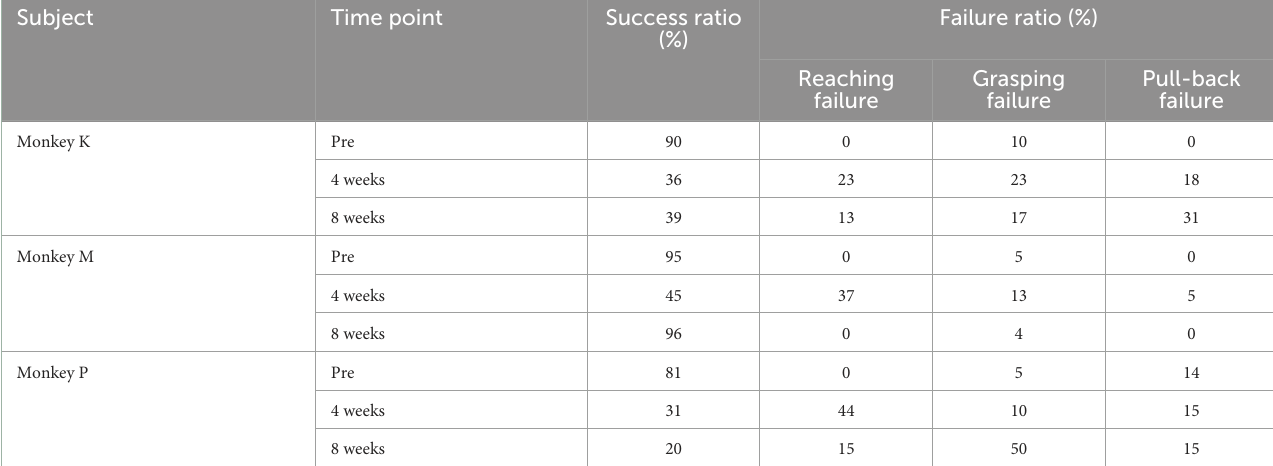
TABLE 3 Details of the pellet-reaching task.